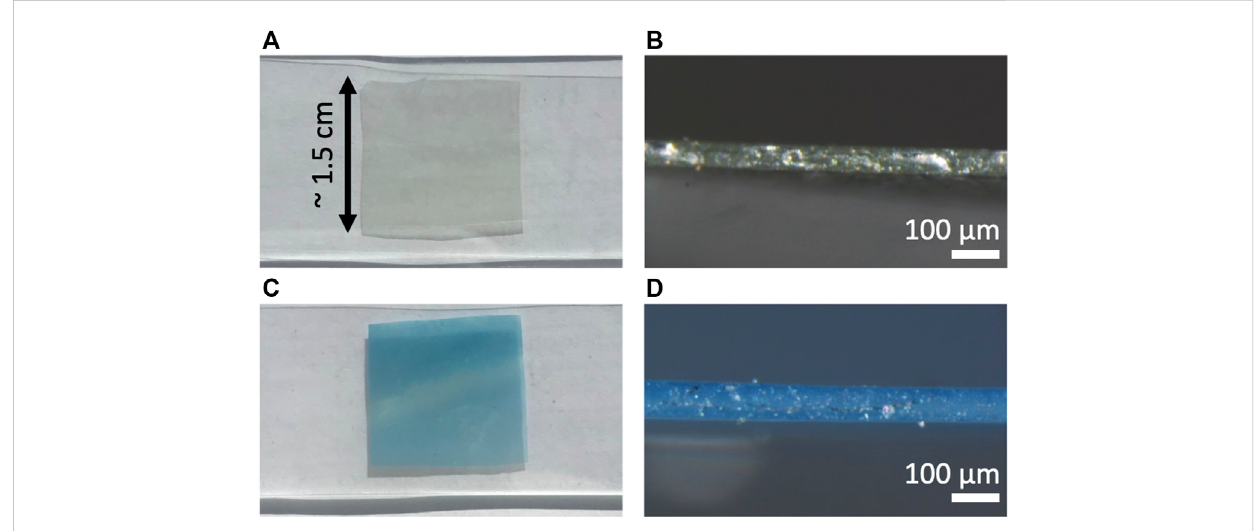
FIGURE 13 Acrylic polyurethane AQ CC 80 coating with 5 wt% Mg-Al/[Fe(CN) 6 ] LDH sensing nanoadditive before (A, B) and after (C, D) immersion in Fe(III) salt solution: top view (A, C) and analysis of the cross-section on the stereo microscope at ×13.5 magni fi cation (B, D)